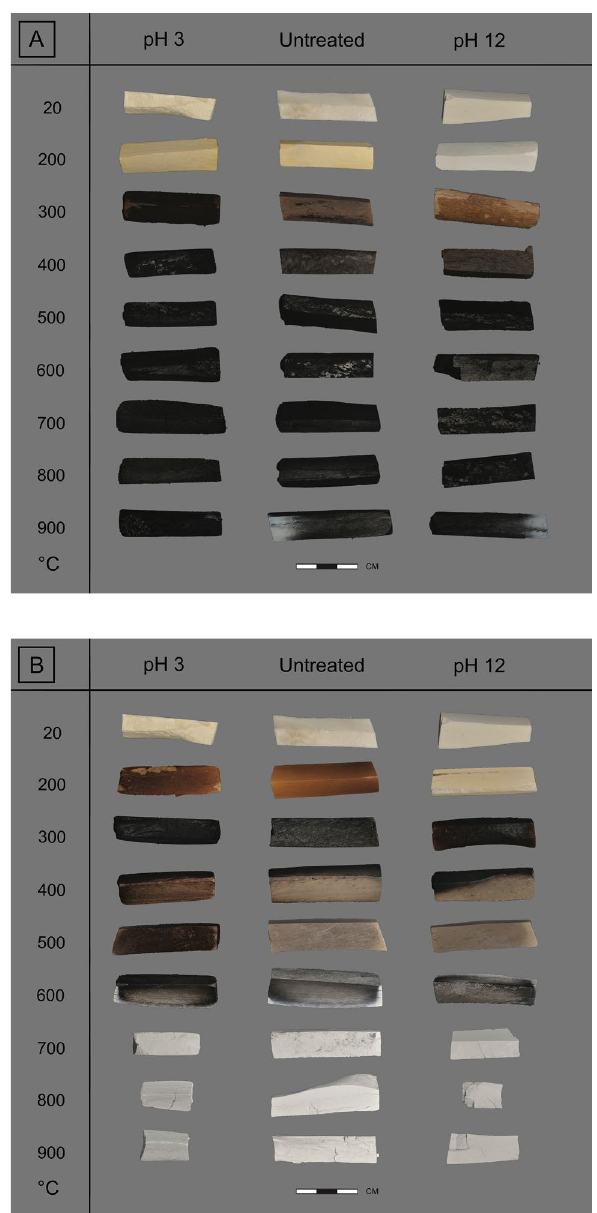
Figure 1. Overview of the variation in colour for charred ( A ) and combusted ( B ) bone exposed to pH 3 and pH 12 conditions. For the control samples exposed to pH 7 conditions ( C ), see the Supplementary Information Fig.